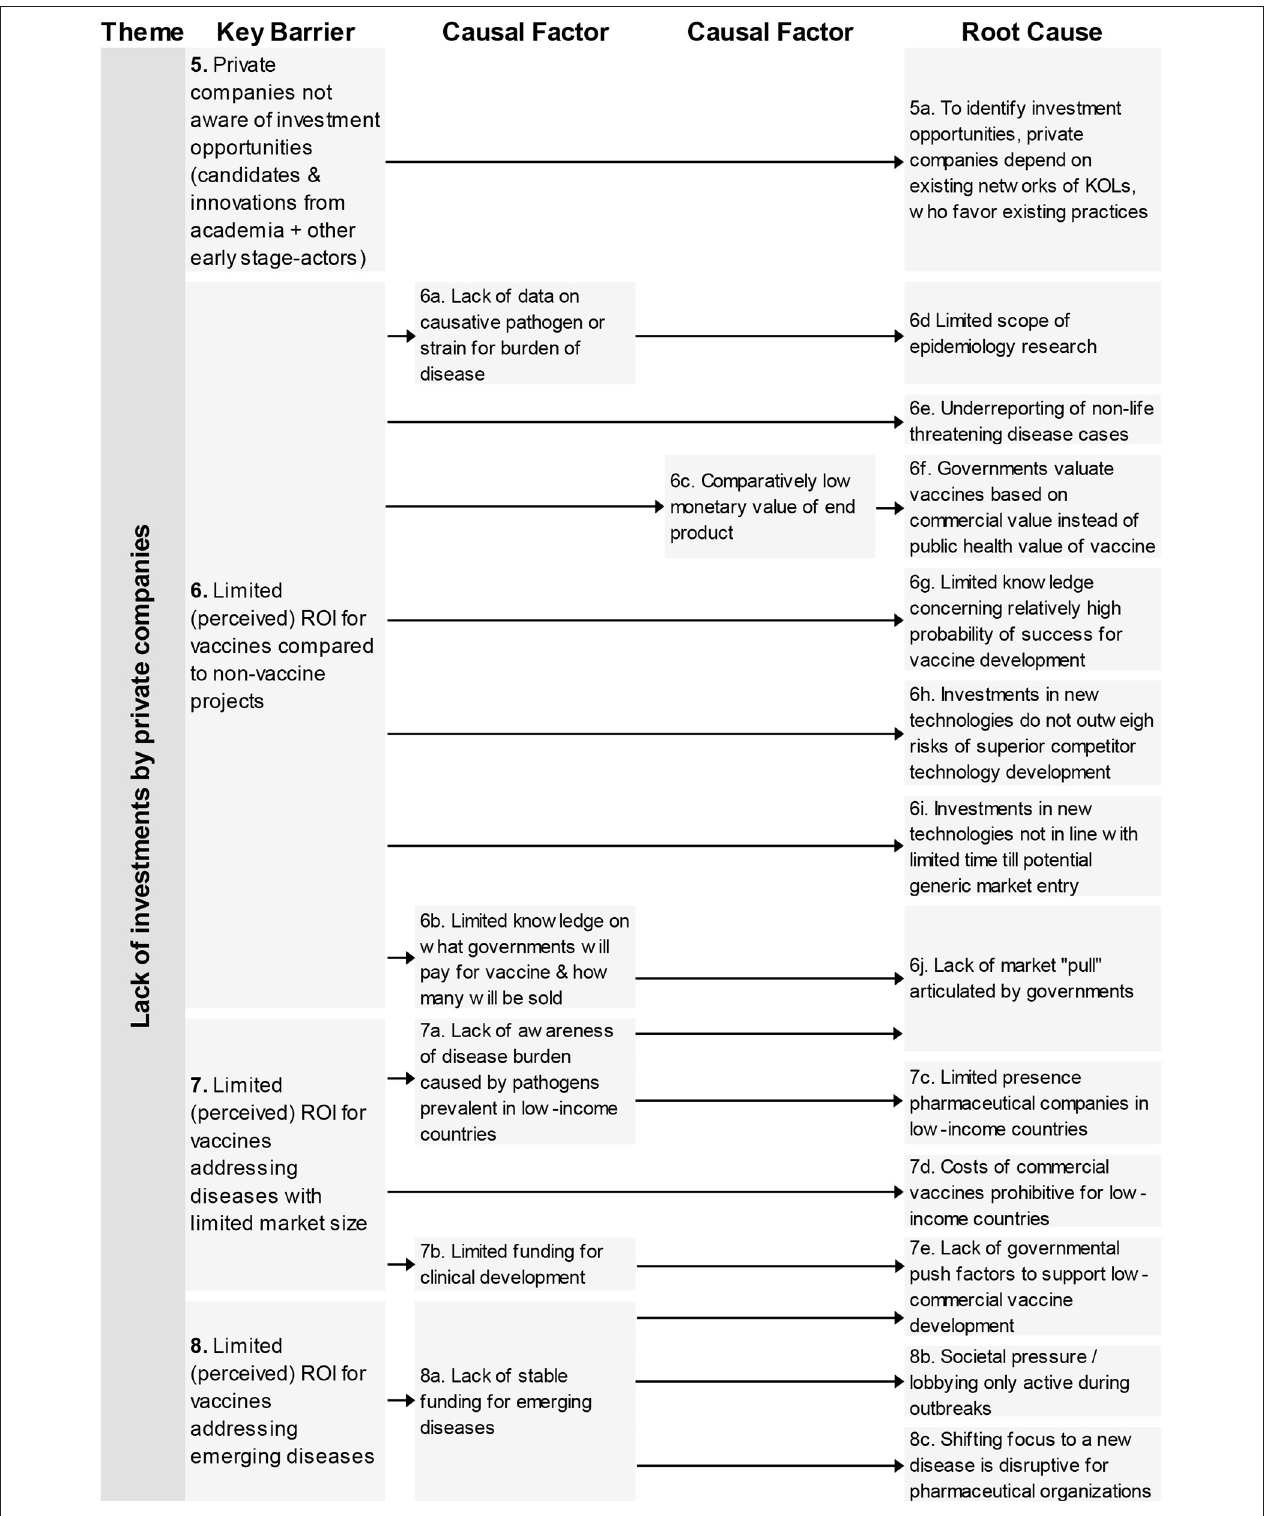
FIGURE 2 | Root-cause analysis of the four barriers classified under the theme “Lack of investments by private companies.” Columns are causally structured. (Left) key barriers are listed that are caused by causal factors (middle), which in turn find their origin in root causes (right).